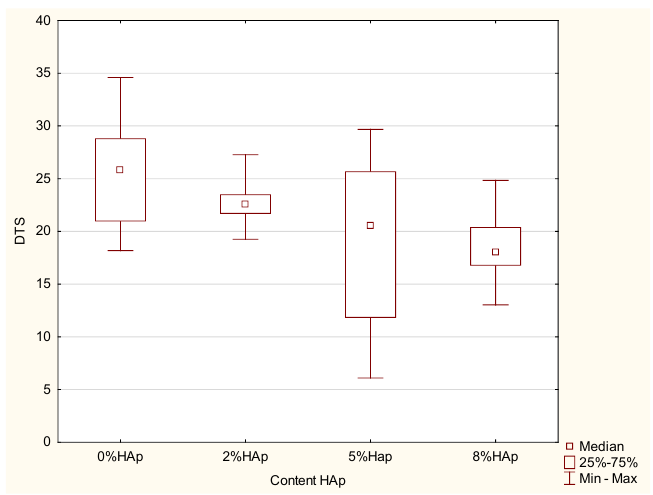
Figure 3. Insignificant differences in DTS among the examined groups.